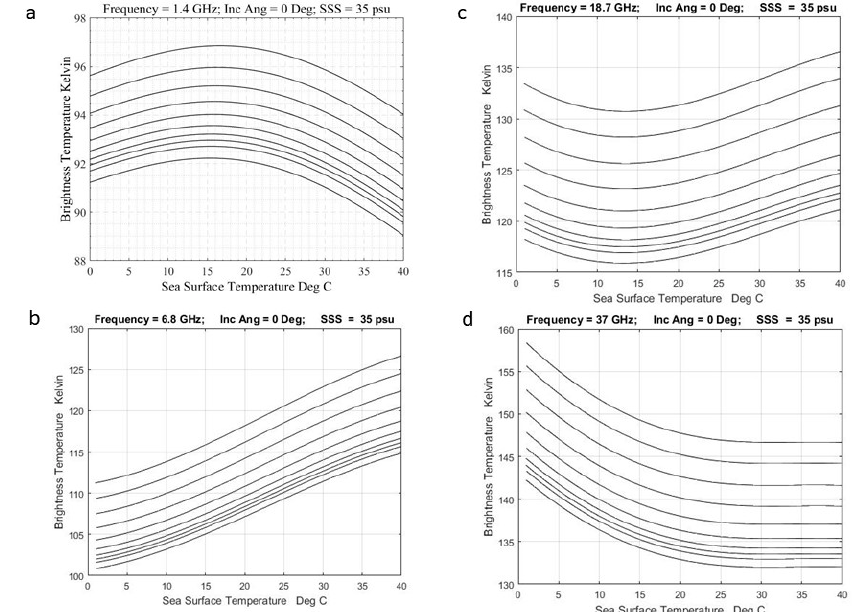
Figure 8. Level curves of TB vs. SST for constant wind speed, WS. The WS increases in steps of 2 m / s starting as zero at the bottom and increasing to 18 m / s at the top. These curves are for nadir (zero incidence angle) and SSS = 35 psu: ( a ) 1.4 GHz; ( b ) 6.8 GHz; ( c ) 18.7 GHz; ( d ) 37.0 GHz.